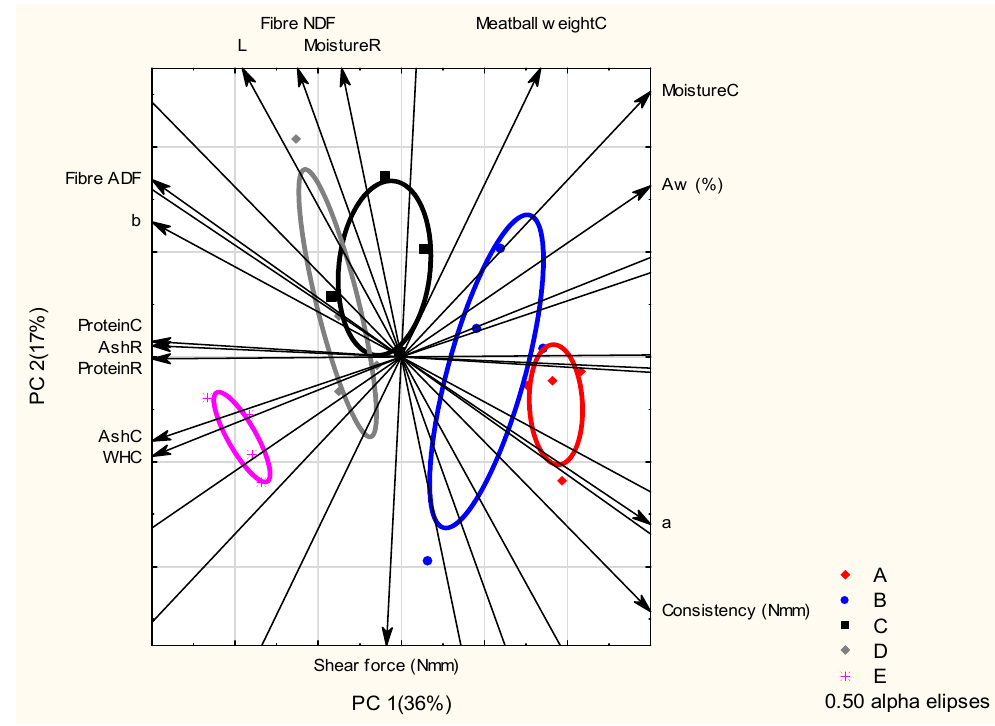
Figure 3. Principal component analysis (PCA) biplot indicating the means of the associations between chemical characteristics and physical properties of five treatments of tapioca substituted with rice bran: A = starch: rice bran (100:0); B = starch: rice bran (75:25); C = starch: rice bran (50:50); D = starch: rice bran (25:75); E = starch: rice bran (100:0).